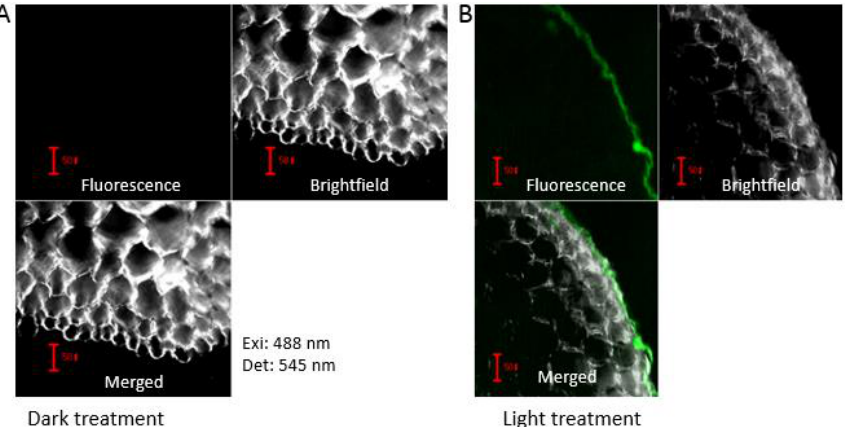
Figure 2. Anthocyanin distribution in the cross-section of the hypocotyl. Samples were prepared through the hand-sliced method and observed using a confocal microscope. Anthocyanin detection using 488 nm excitation and 545 nm emission. Samples of dark ( A ) and light ( B ) treatment viewed with anthocyanin detection field, bright field, and merged images. The scale bars in the figure represent 50 µm. The green color is indicative of anthocyanin presence.